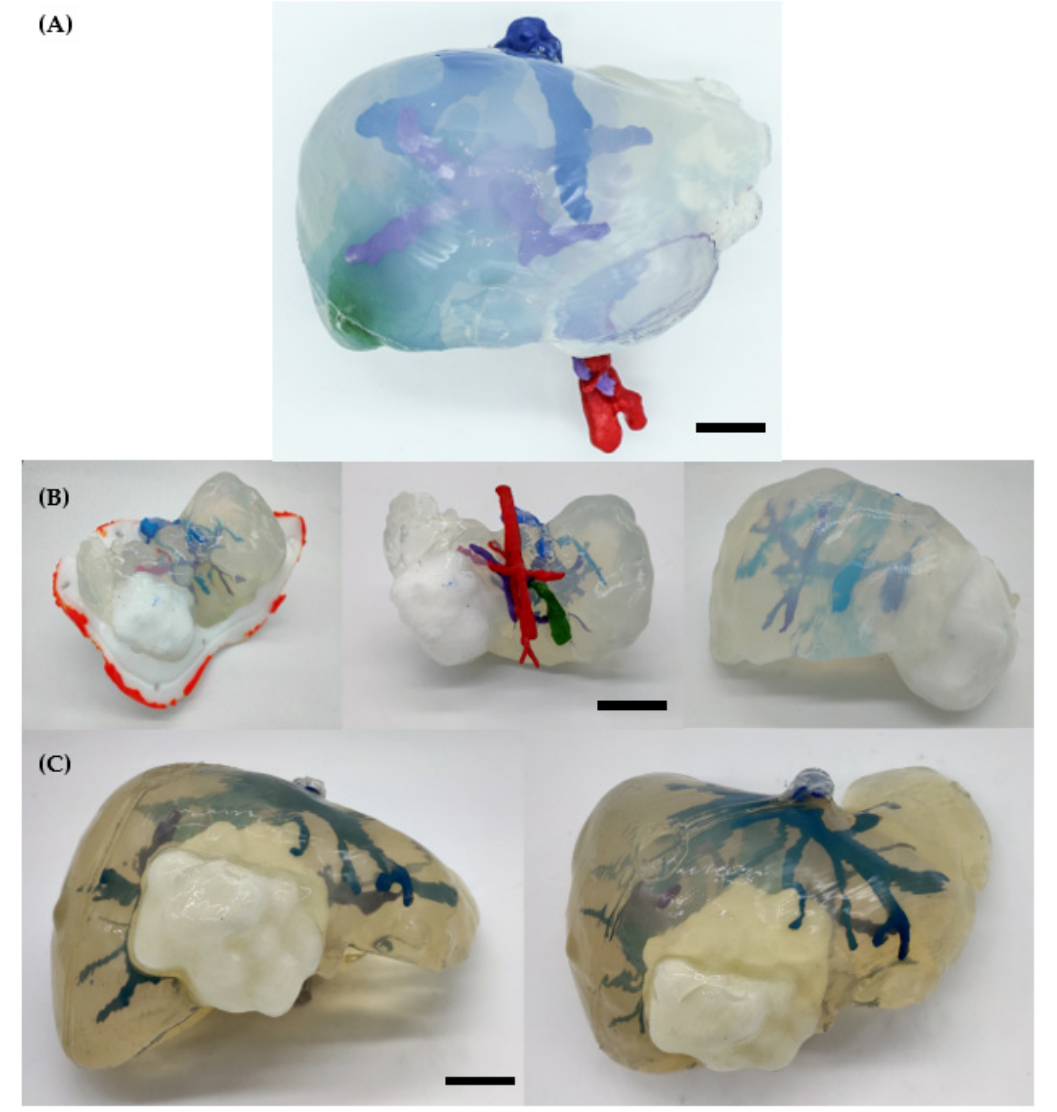
Figure 7. Surgical planning prototypes. ( A ) Case #1: Rhabdomyosarcoma (bar corresponds to 3 cm). ( B ) Case #2: Hepatoblastoma (bar corresponds to 5 cm). ( C ) Case #3: Mesenchymal Hamartoma (bar corresponds to 3 cm).